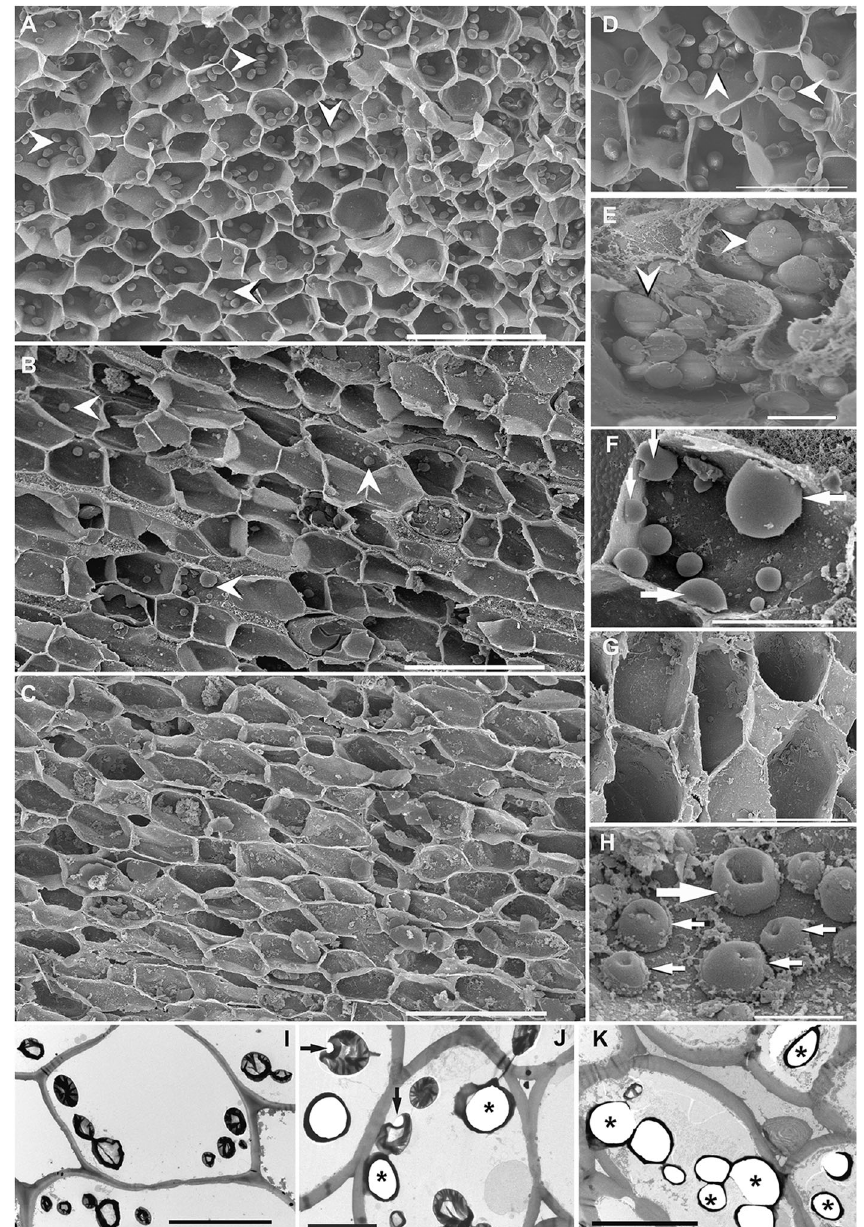
Fig. 2 Posidonia oceanica rhizome. A – H Scanning electron microscopy (SEM). I – J Transmission electron microscopy (TEM). Transverse section of an apical portion of P. oceanica rhizome showing the opened cortical cells. A , D , E , I Control at 120 h after sound exposure. B , F , J Forty-eight hours after sound exposure. H Ninety-six hours after sound exposure C, G, K One-hundred-and-twenty hours after sound exposure. A Cortical cells present a high density of starch grains (arrowheads). B The number of starch grains (arrowheads) had considerably decreased. C Cortical cells have totally lost the starch grains. D , E Details of A, showing well-formed (or round) starch grains (arrowheads). F , H Details from B. F Some starch grains presented a deformed structure without the typical spherical shape (arrows). G Detail from C, showing the empty columella cells. H The remaining abnormal starch grains presenting an empty aspect (large arrow) or holes (small arrows) at the surface. I All cortical cells of control rhizomes contained starch-prominent starch grains. J Some of the starch grains had partially (arrows) or totally (asterisk) lost the starch. K All of the starch grains presented an empty structure (asterisk). Scale